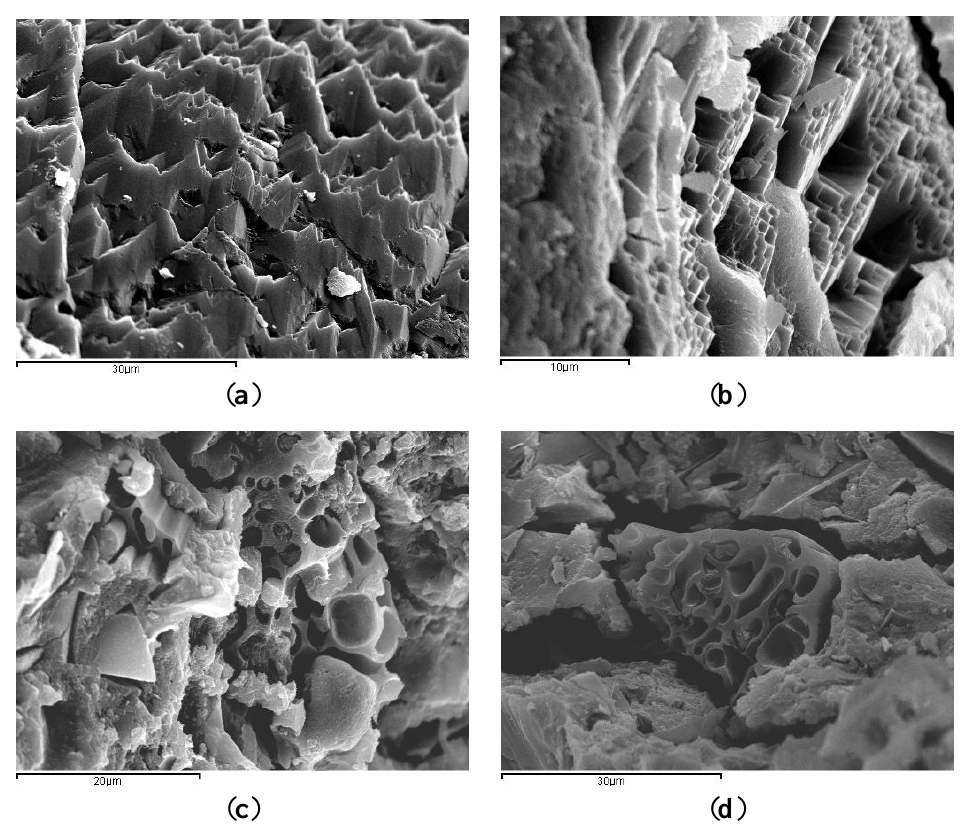
Figure 7. SEM micrographs of alkali-activated binders of BFS + SCBA cured at 65 °C